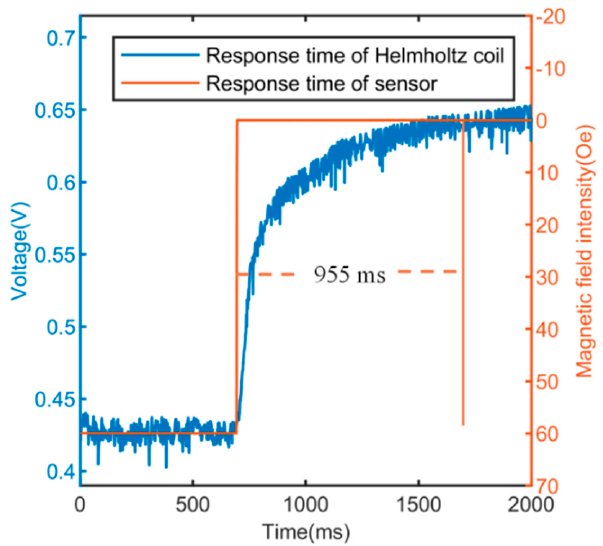
Figure 7. Response time of the sensor and Helmholtz coils from 60-0 Oe.